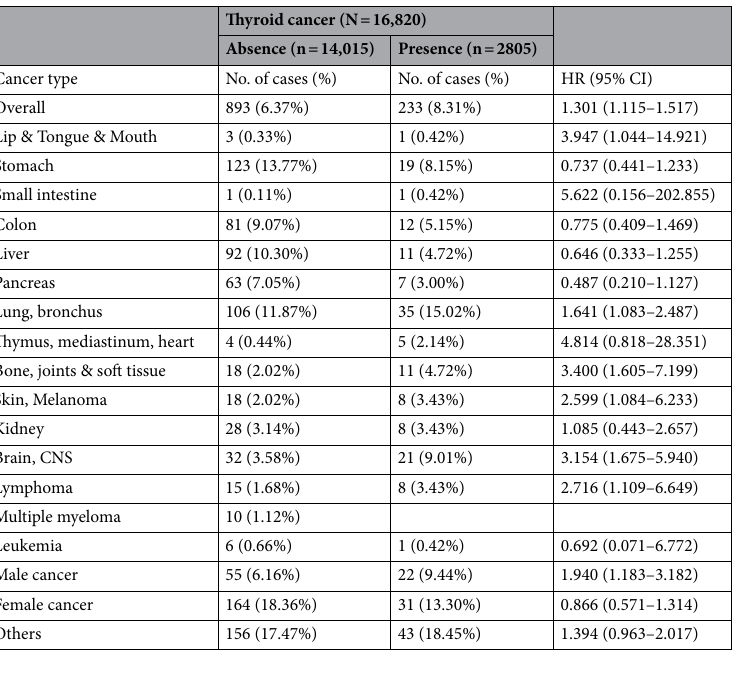
Table 4. Risk estimation of cancer in patients with NAFLD or dyslipidemia according to thyroid cancer in Korean national cohort. HR, hazard ratio; Total (%) = other primary cancer pts. / total pts. Cancer type (%) = specific type pts./other primary cancer